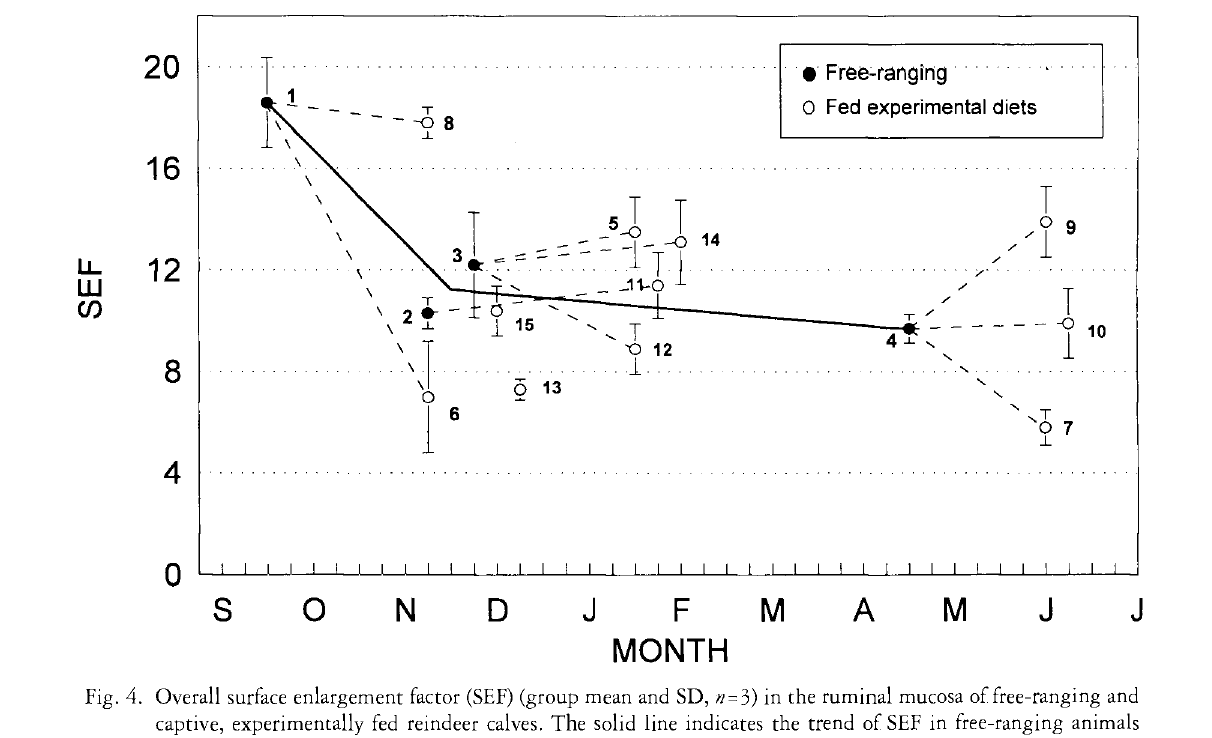
Fig. 4. Overall surface enlargement factor (SEF) (group mean and SD, « = 3) in the ruminal mucosa of free-ranging and captive, experimentally fed reindeer calves. The solid line indicates the trend of SEF in free-ranging animals from September to April. Dashed lines show connections between free-ranging groups ("reference groups") and groups of experimentally fed animals, and indicate the trend in SEF change during the feeding